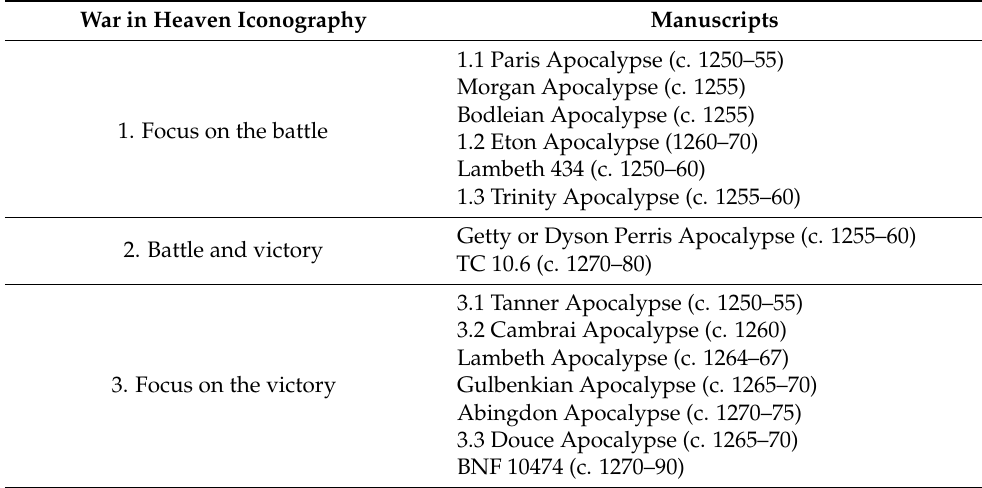
Table 2. Grouping of Anglo-Norman illustrated Apocalypse manuscripts on the basis of the War in Heaven iconography examined in the